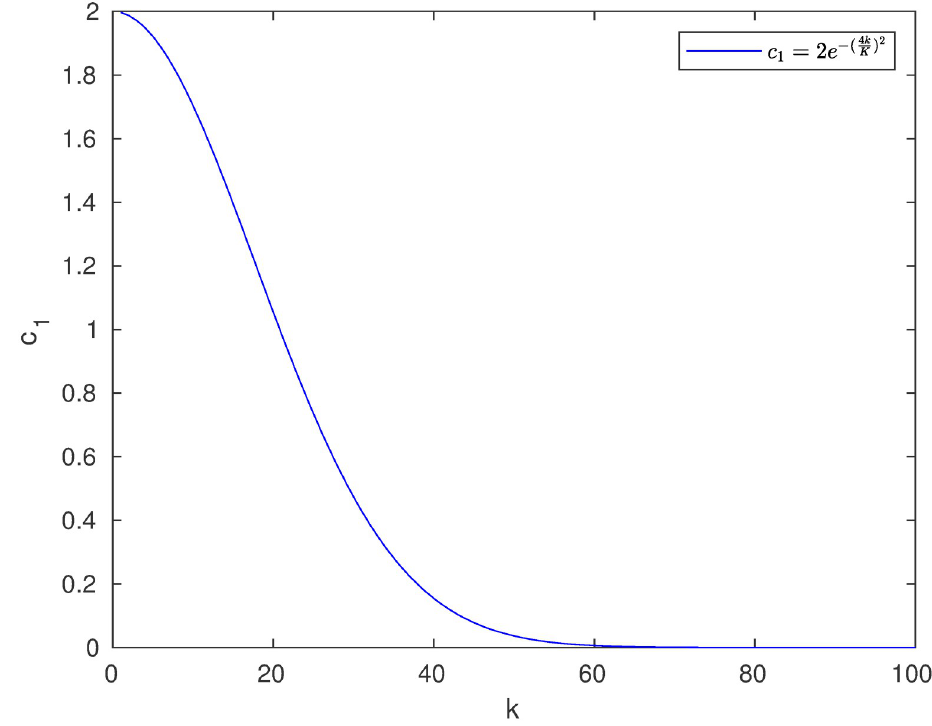
Fig 1. Change in value of c 1 during